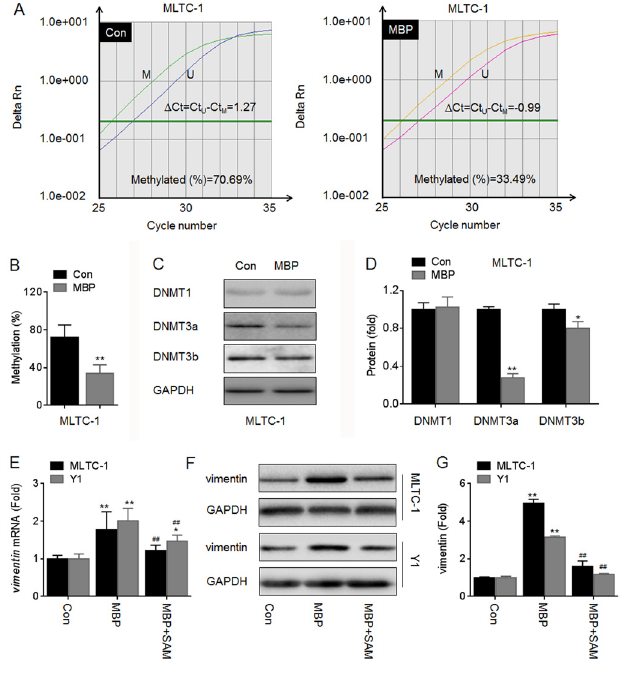
Fig 6. MBP improved the expression of vimentin by DNA demethylation. (A-D), MLTC-1 cells were exposed to 1000 nM MBP for 24 h, the methylation status of vimentin promoter was determined in triplicate by qMSP (A and B). Annotation, methylated (M); unmethylated (U); the percentage of methylation in a sample was estimated using the following formula: methylation (%) = (M/M+U) ×100% = [1/(1+U/M)] ×100% = [1/(1 +2 Δ Ct )] ×100%. (C and D), Western blots analysis and relative protein levels of DNMT1, DNMT3a, and DNMT3b. * p < 0.05 and ** p < 0.01 compared with medium control cells. (E-G), MLTC-1 and Y1 cells were exposed to 1000 nM MBP in the presence or absence of 200 μ M SAM for 24 h, respectively. (E) qRT-PCR analysis in triplicate of vimentin mRNA. (F) Western blots analysis and (G)relative protein levels of vimentin. * p < 0.05 and ** p < 0.01 compared with medium control cells; ## p < 0.01 compared with cells exposed to MBP